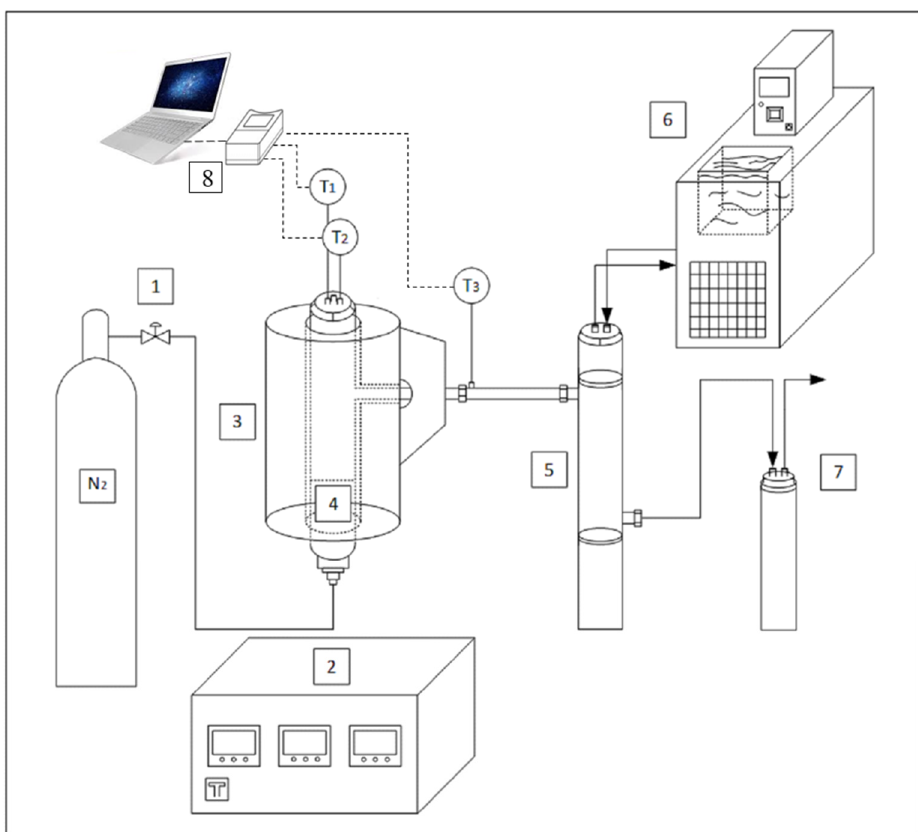
Figure 1. Experimental setup for torrefaction studies.